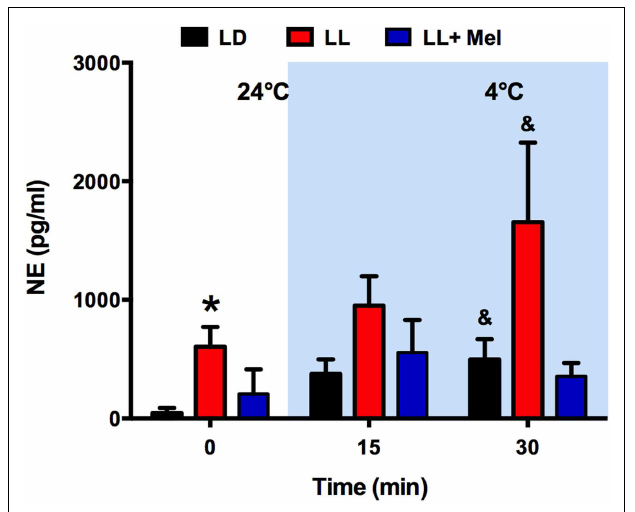
FIGURE 4 | Response of plasma norepinephrine (NE) concentration to exposure to 4°C in 5days old lambs . Data are means ± SEM. LD, newborns gestated in ewes exposed to photoperiod 12:12; LL, newborns gestated in ewes kept in continuous light from 60% gestation to term and LL + Mel, newborns gestated in ewes kept in continuous light but receiving an oral dose of 12mg melatonin at 1700h. N = 4 per group. Samples were taken at the end of 1h exposure to 24°C, and at 15 and 30min of exposure to 4°C. * P < 0.05 vs. LD; & P < 0.05 vs. values at 24°C. ANOVA andTukey’s test.